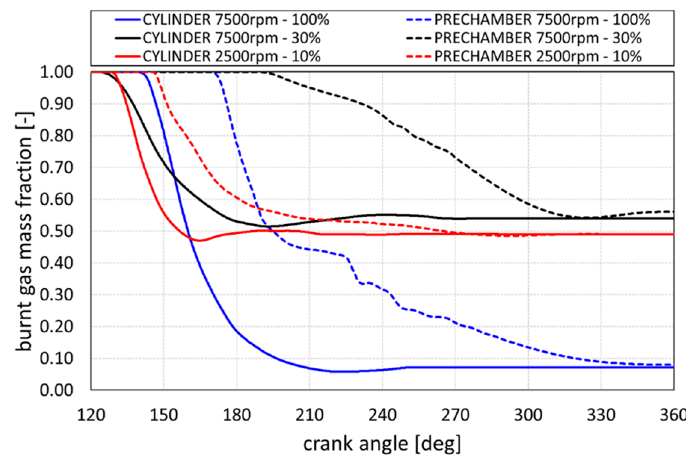
Figure 6. Mass fraction of burnt gas (MFBG) trends inside the main chamber (continuous lines) and the PN8 prechamber (dashed lines) for the three engine operating points.